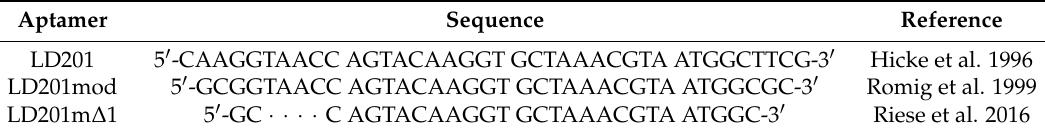
Table 1. Sequences of the various shortened variants of the originally described aptamer. Aptamer